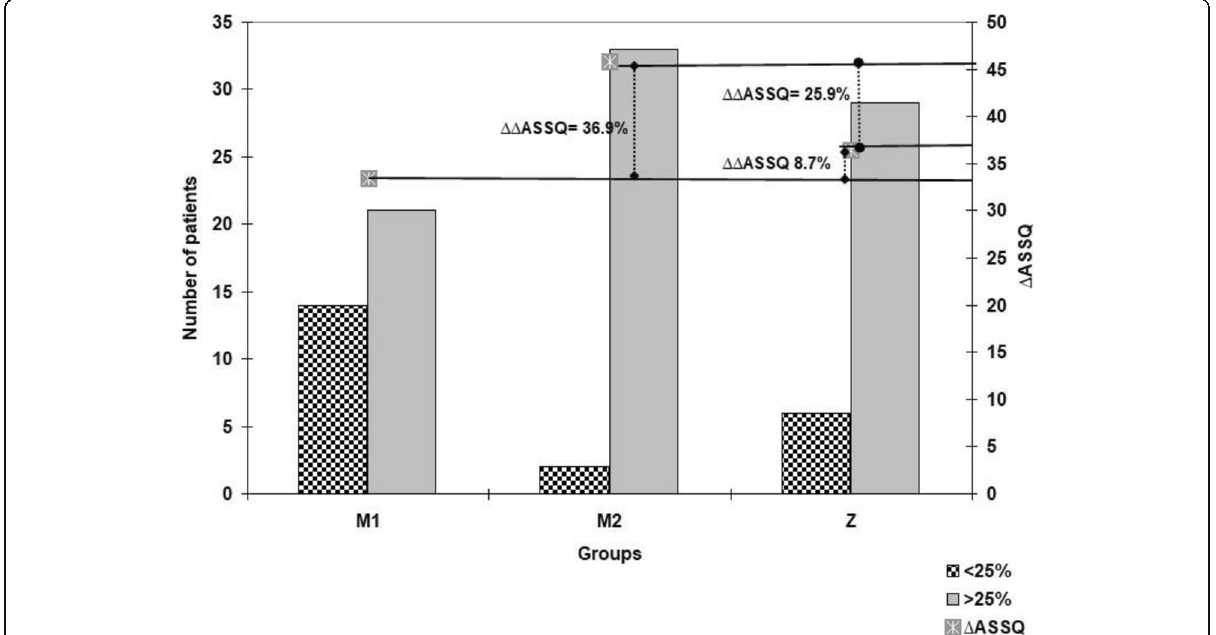
Fig. 2 Percentage of decreased Anxiety Specific to Surgery Questionnaire (ASSQ) score after receiving premedication